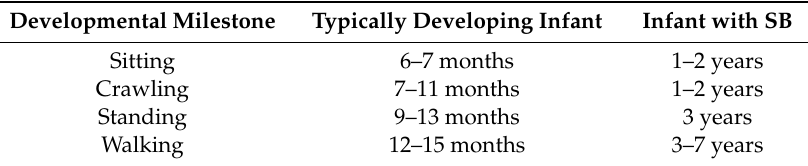
Table 1. Developmental milestones (adapted from Goracke et al.